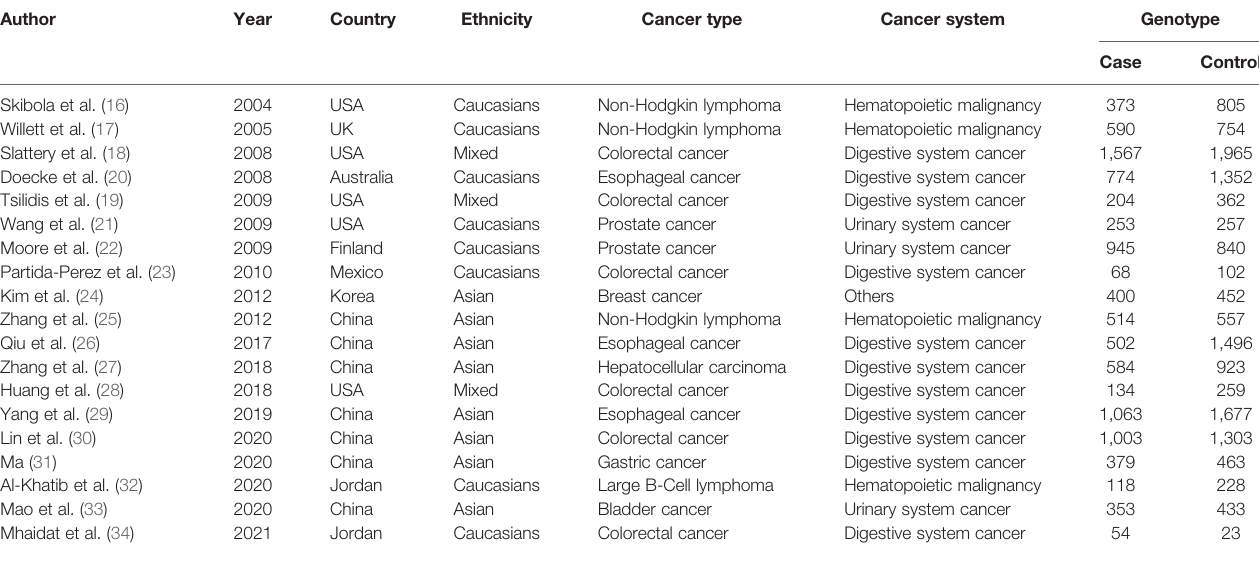
TABLE 1 | The characters of included studies in the meta-analysis.